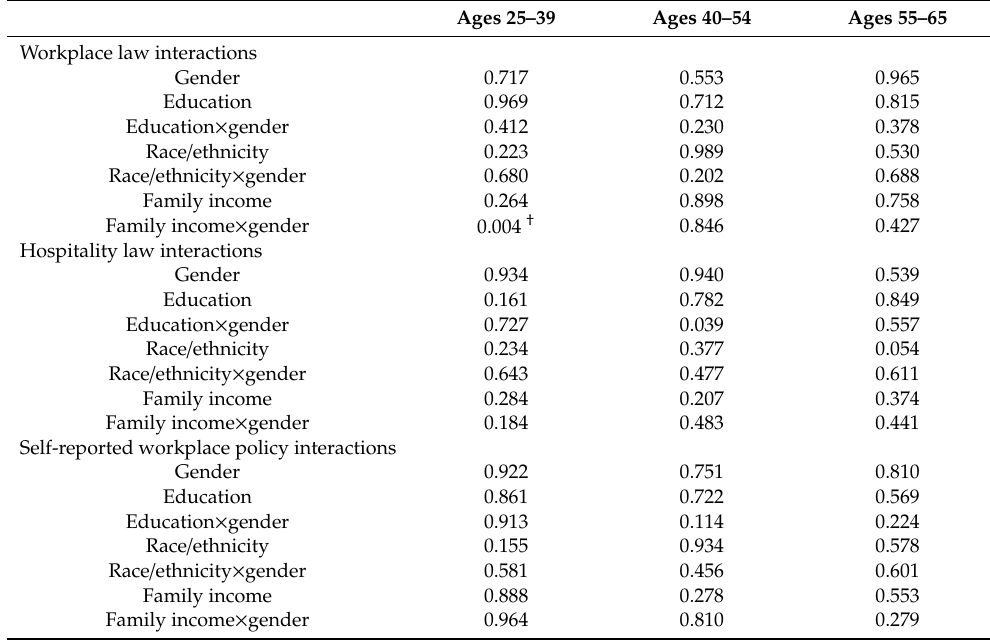
Table 3. p -values associated with interaction terms across age-stratified models a